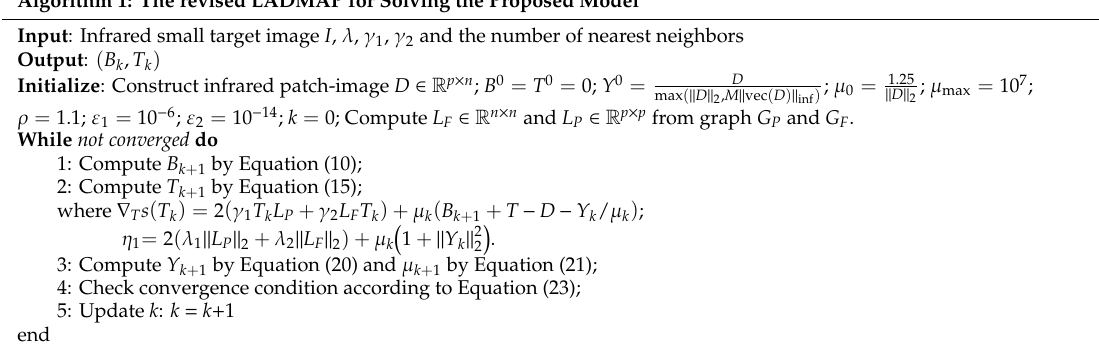
Algorithm 1: The revised LADMAP for Solving the Proposed